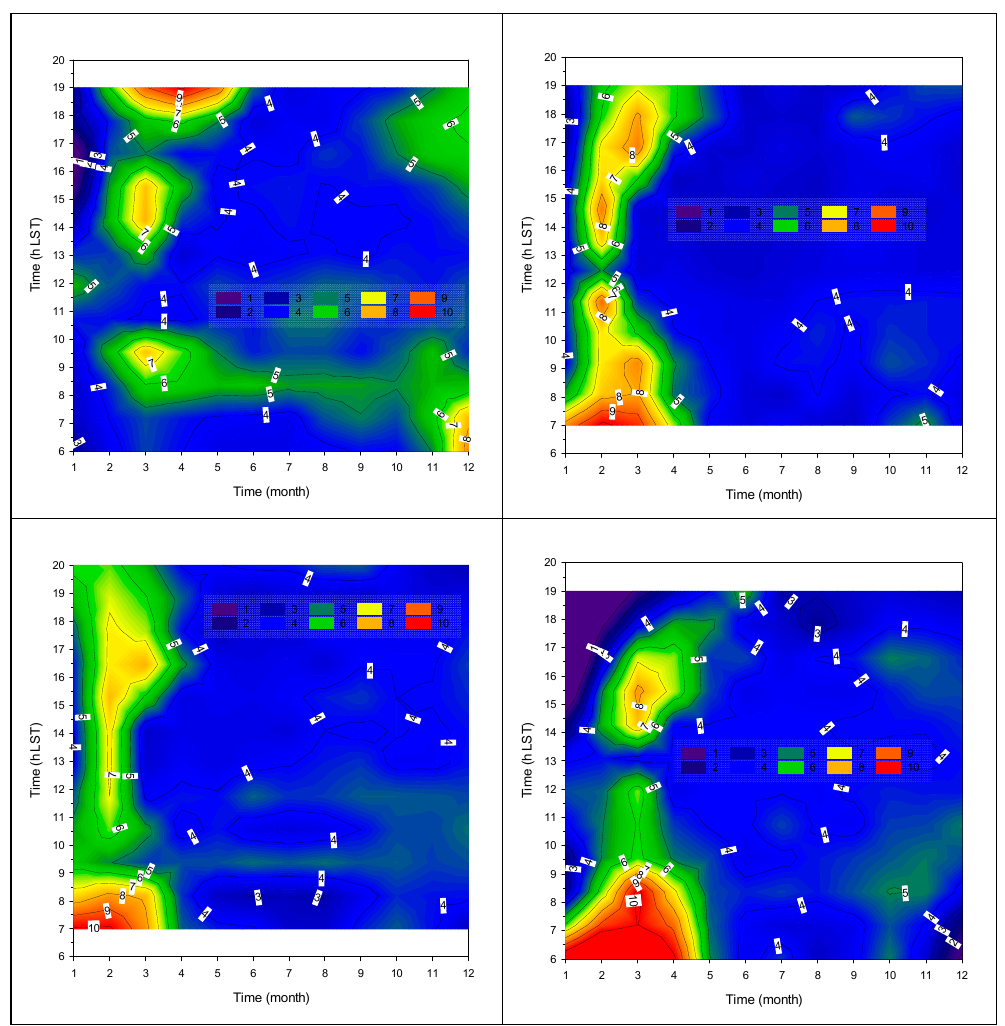
Figure 4. Month–hour diagrams of the T L values in a Typical Atmospheric Turbidity Year (TATY) under all-sky conditions in climatic zone A: first raw, Irakleio (left), Kalamata (right); climatic zone B: second raw, Agrinio (left), Lesvos (right); climatic zone C: third raw, Alexandroupoli (left), Tripoli (right); climatic zone D: fourth raw: Kastoria (left), Serres (right). The color code refers to the T L levels, which have been kept in the range 1 ≤ T L ≤ 10. The 06.00–20.00 h LST (Local Standard Time = Universal Time + 2h for Greece) interval limitation in the graphs is due to the adopted criterion γ ≥ 5°.